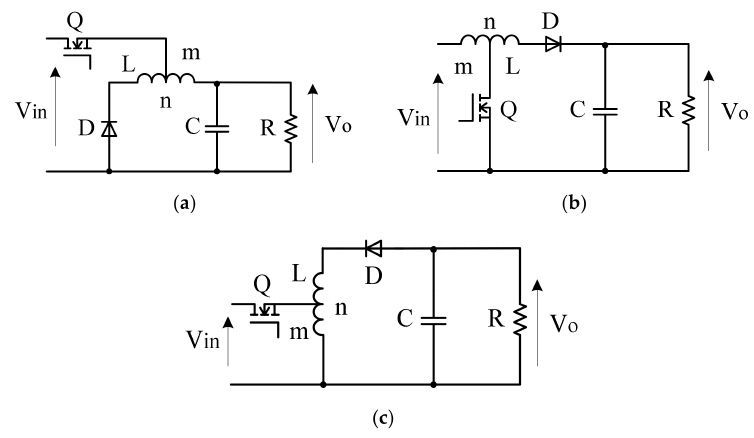
Figure 2. General topology of tapped inductor for three basic SMPC topologies. ( a ) Buck converter; ( b ) Boost converter; ( c ) Buck-boost